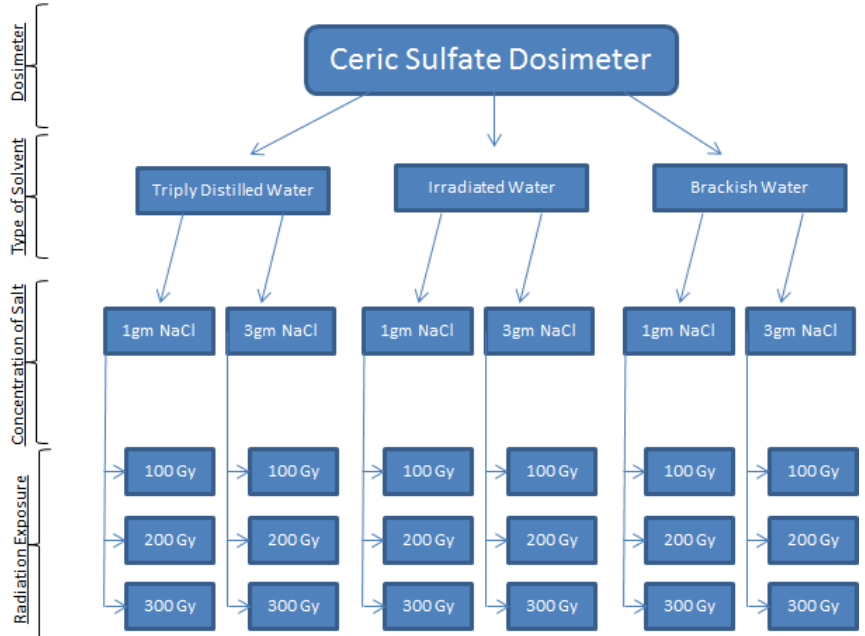
Figure 1: Preparation scheme of Ceric Sulfate